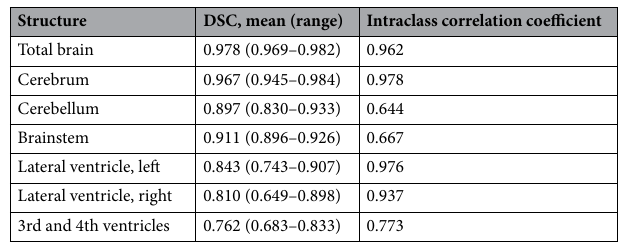
Table 2. Dice similarity coefficient (DSC) and volume-based intraclass correlation coefficient (ICC) for the automatic segmentations compared to the manual segmentations (n = 10).